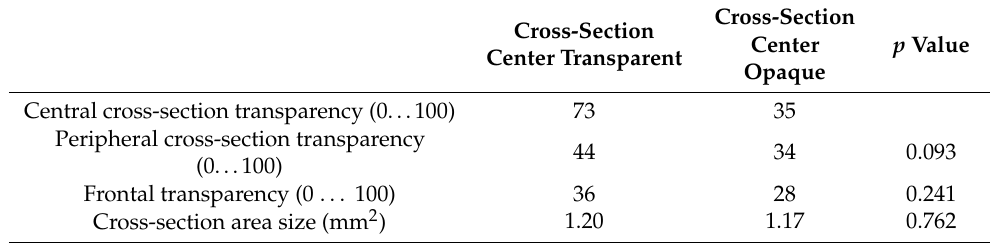
Table 3. Comparison of different morphological results among our samples when separating them in to two groups based on the central transparency of their cross-sections. The mean results of trans- parency (ranging from 0 = most opaque sample to 100 = Transparent) and cross section area size were compared. Statistical significance of mean results was calculated with t -Test.